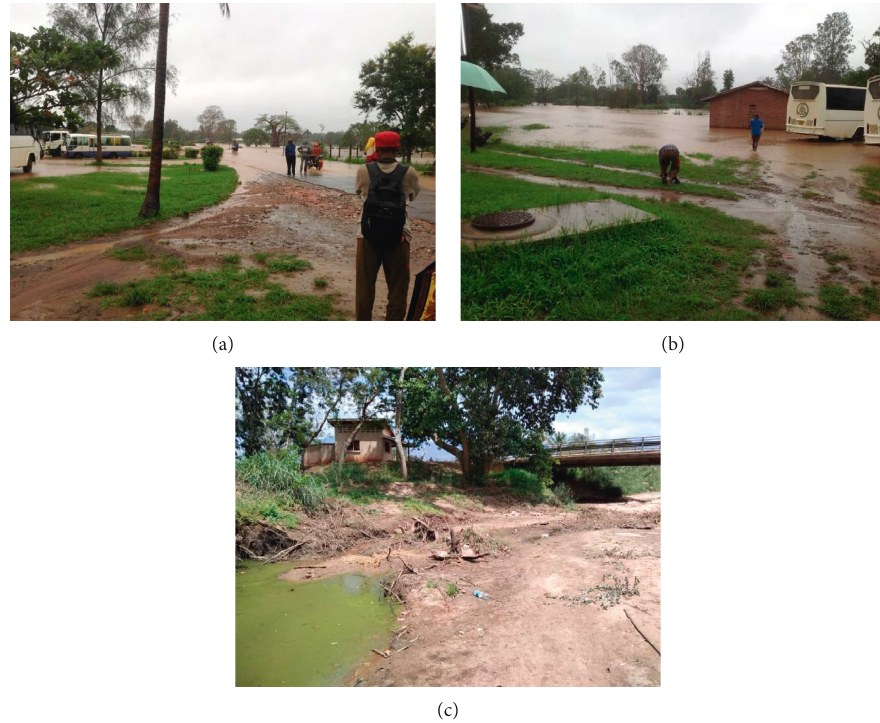
Figure 11: (a) Photos taken (downstream Mindu Dam) on morning hours just after the rainfall on the 11th of January 2018. No one (anecdotal observation) could have crossed the bridge (Julius Nyerere Freedom Bridge) to/from Solomon Mahlangu College of Science and Education, Mazimbu, from/to Morogoro Town; (b) for the first time (word of mouth from an aged personnel with 32years of working experience), the security offices in the campus went flooded and (c) observation at the same point just few months after rainy season (March, April, and